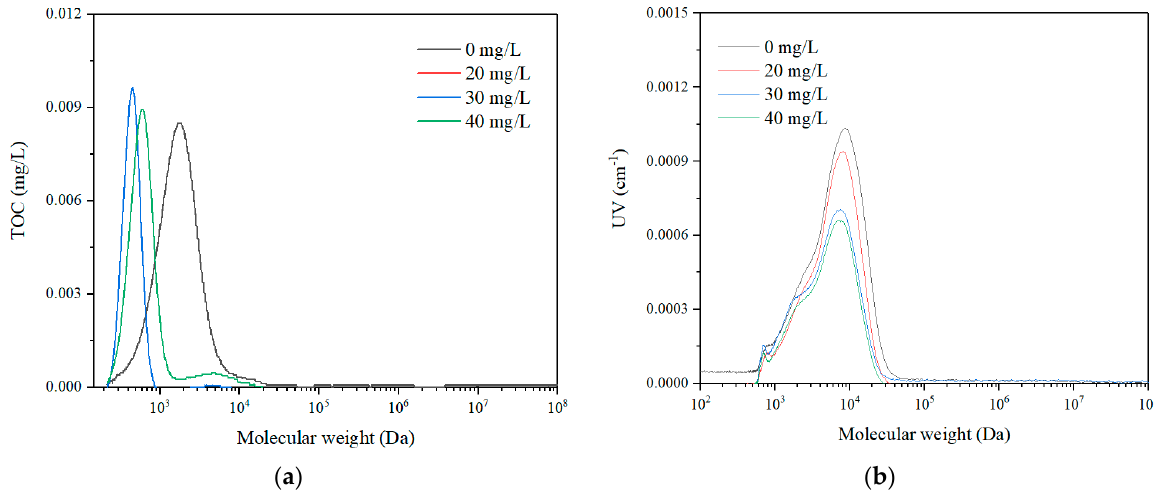
Figure 9. Molecular weight distribution of SA with a rotation speed of 30 r/min and different coagulant dosages, ( a ) TOC detection, 3 h, and ( b ) UV detection, 2 h.